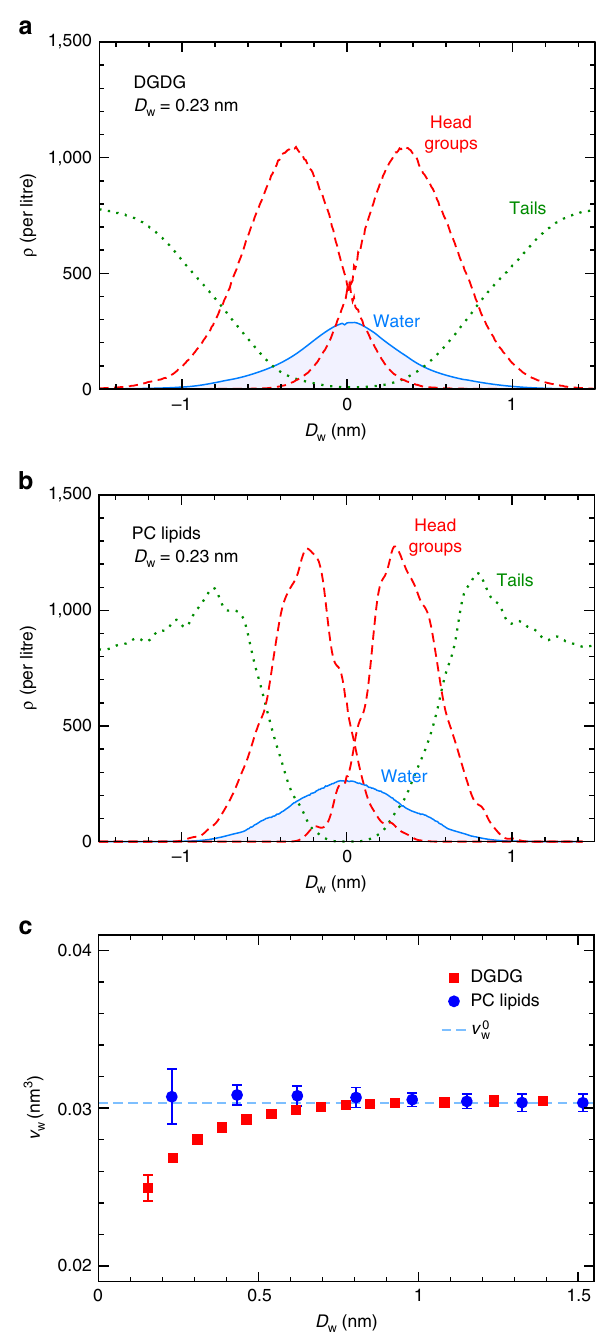
Figure 3 | Incorporation of the hydration water. Density profiles of water, headgroups and hydrocarbon chains in hydrated DGDG ( a ) and PC lipid ( b ) membranes at D w ¼ 0.23nm. ( c ) Partial water volume v w as a function of D w for DGDG and PC lipids. Error bars represent 1 s.d. of